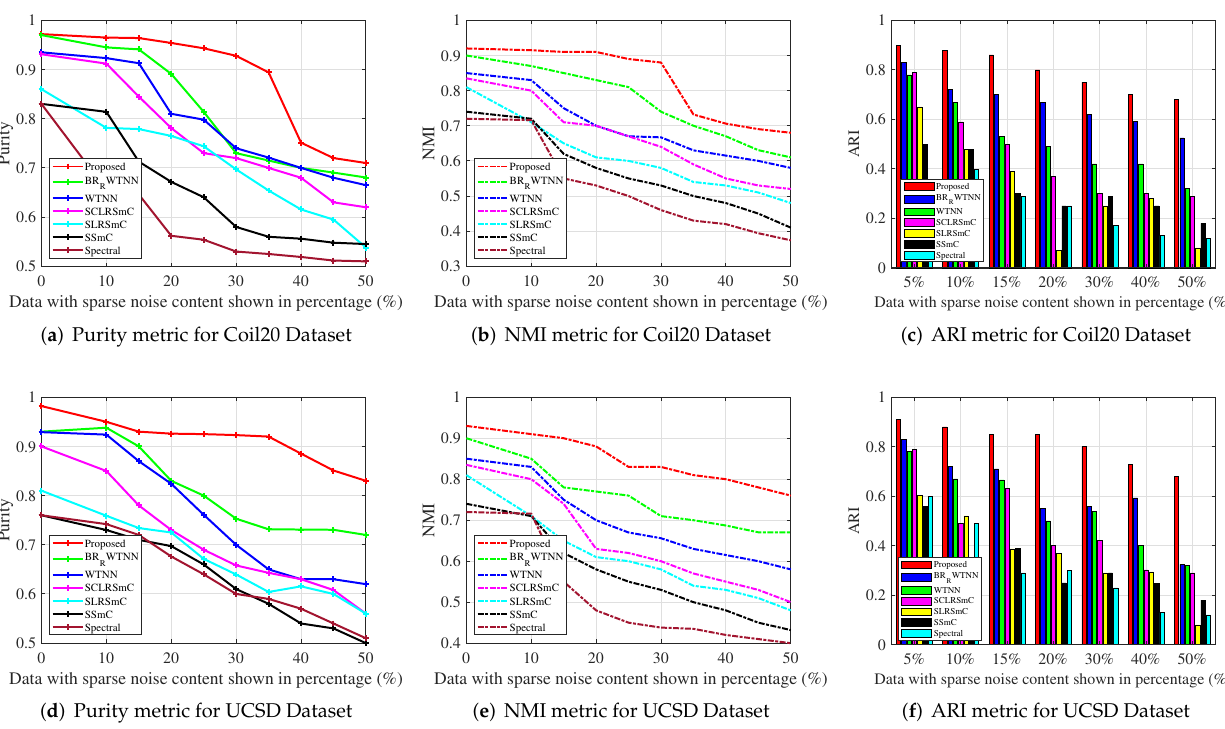
Figure 5. Quantitative comparison of purity, NMI and ARI metrics of the proposed method and state-of-the art algorithms under various levels of sparse noise using Coil20 and UCSD